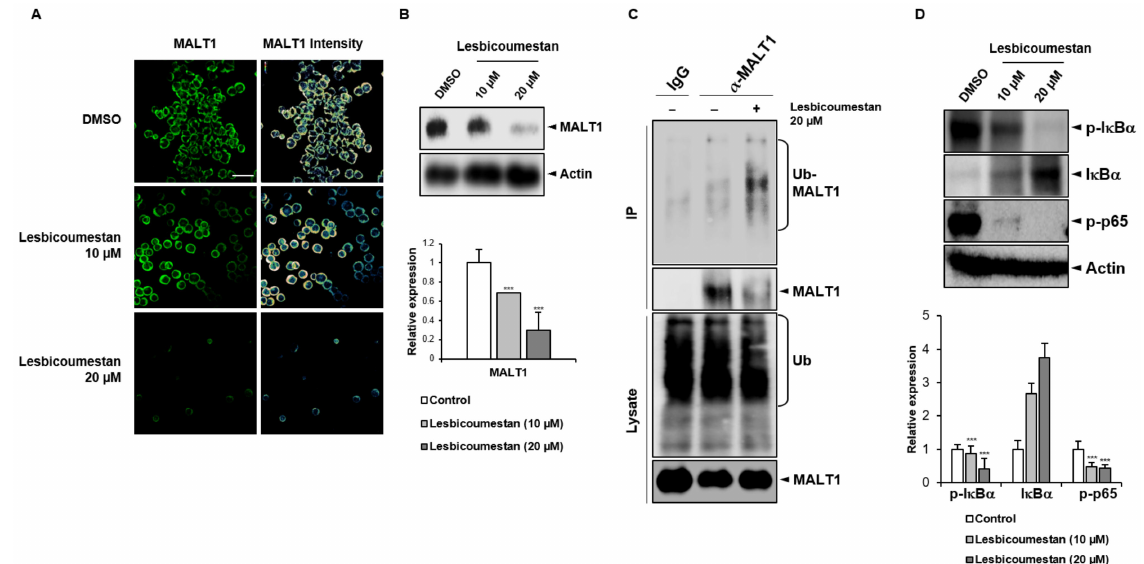
Figure 4. Lesbicoumestan-inhibited MALT1/NF- κ B in Jurkat cells. ( A ) Immunofluorescence staining of MALT1 in Jurkat cells treated with 10 µ M and 20 µ M lesbicoumestan. ( B ) MALT1 expression following lesbicoumestan treatment of the cells (10 µ M and 20 µ M) as analyzed via Western blots. ( C ) SDS lysates of the indicated lines were subjected to control treatment or MALT1 antibody binding and protein A/G purification. Immunoblotting was performed to analyze purified proteins and total lysates. ( D ) Expression levels of p-I κ B α , I κ B α , and p-p65 after the cells were treated with lesbicoumestan (10 µ M and 20 µ M) as determined using whole-cell lysates. n = 3, *** p < 0.001 vs. control